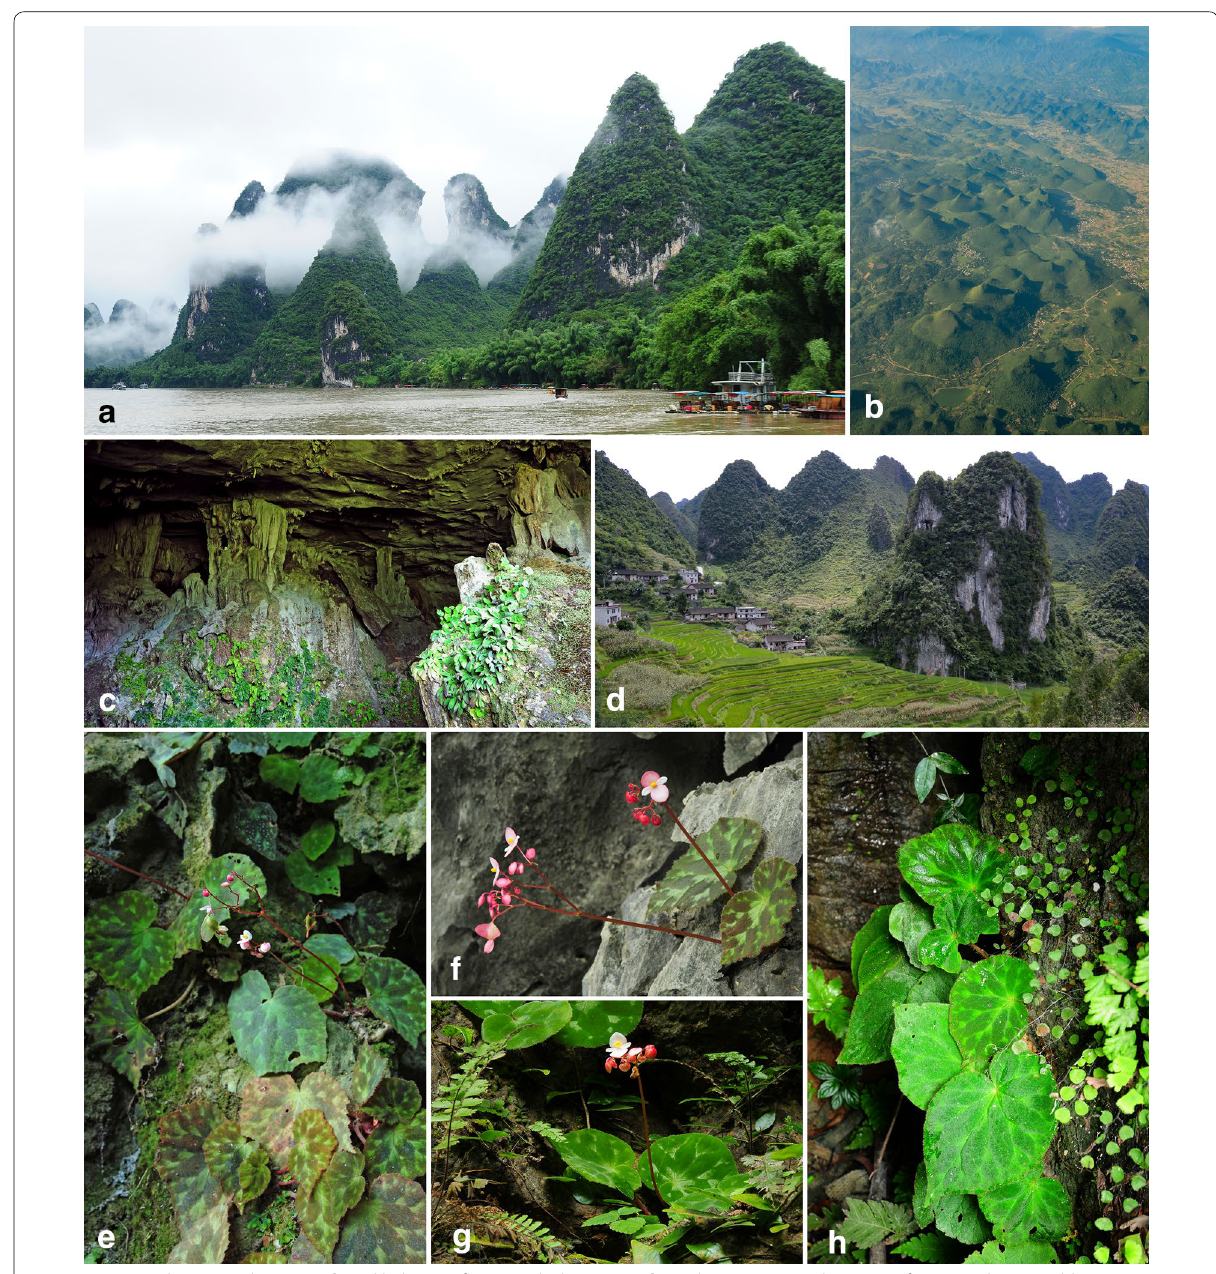
Fig. 1 Guangxi’s limestone karsts ( a – d ) and habitats of Begonia luzhaiensis ( e – h ). a The picturesque limestone fengcong karst (Waltham 2008) along the Li River in Guangxi, China is a habitat for many limestone plants, including B. luzhaiensis . b Aerial photography taken before descending into Guilin Airport, Guangxi, showing the fragmented and cockpit‑like karst landscape. c The entrance of a limestone cave in Luzhai County, Guangxi where the LZ population (Fig. 2) was sampled. This cave is also the type locality of one rare gesneriad, Chirita luzhaiensis ( luzhaiensis ) (Huang et al. 2010). d Rice terraces in Tian’e County, Guangxi, showing the typical agricultural practices in the region and degraded limestone forest in a limestone karst. e B. luzhaiensis grows in the limestone cave (Fig. 1c) in Luzhai County (LZ in Fig. 2). f B. luzhaiensis grows on a limestone outcrop in Xincheng (XC in Fig. 2). g B. luzhaiensis grows in the entrance of a limestone cave in Rongshui County (RS in Fig. 2). h B. luzhaiensis grows on the base of a limestone tower along the Li River (YS in Fig.